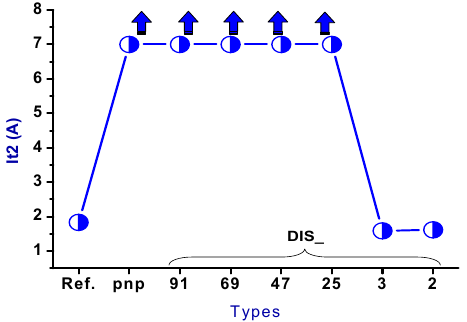
Figure 10. I t2 diagrams of the nLDMOS-SCR ( p-n-p -arranged) tested samples.